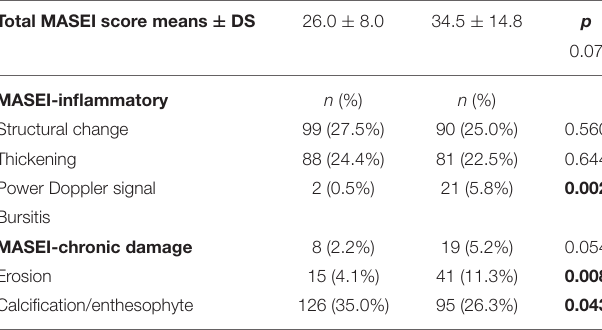
TABLE 3 | MASEI score in 360 entheses in gout compared with